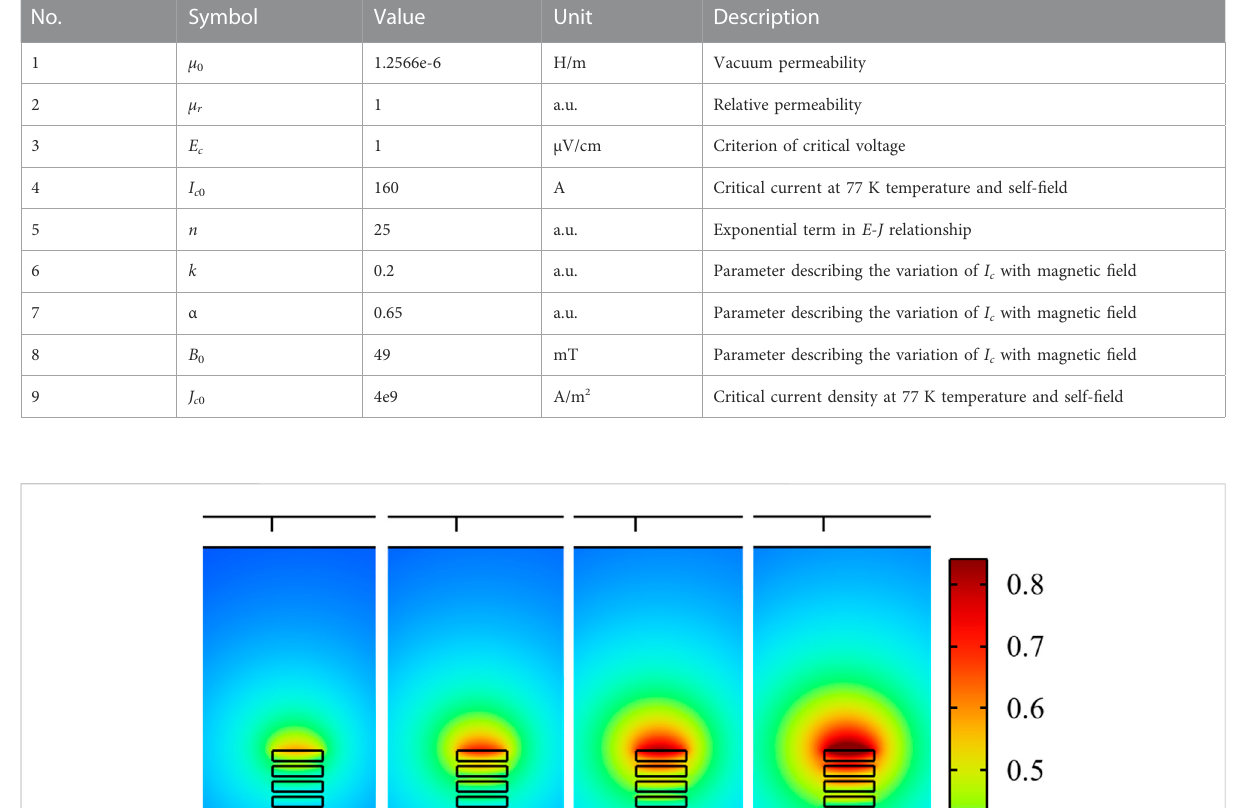
TABLE 3 Electromagnetic parameters involved in simulation. No.